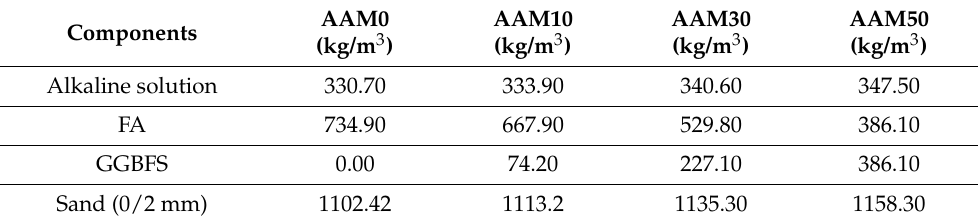
Table 3. AA mortar mix designs for 1 m 3